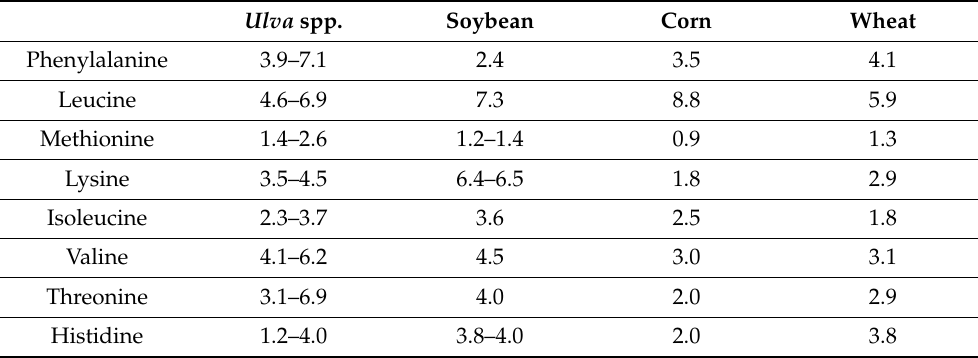
Table 2. Essential amino acids composition of the macroalgae Ulva spp. and conventional foodstuffs (g/100 g proteins). Ulva spp. Soybean Corn Wheat Phenylalanine